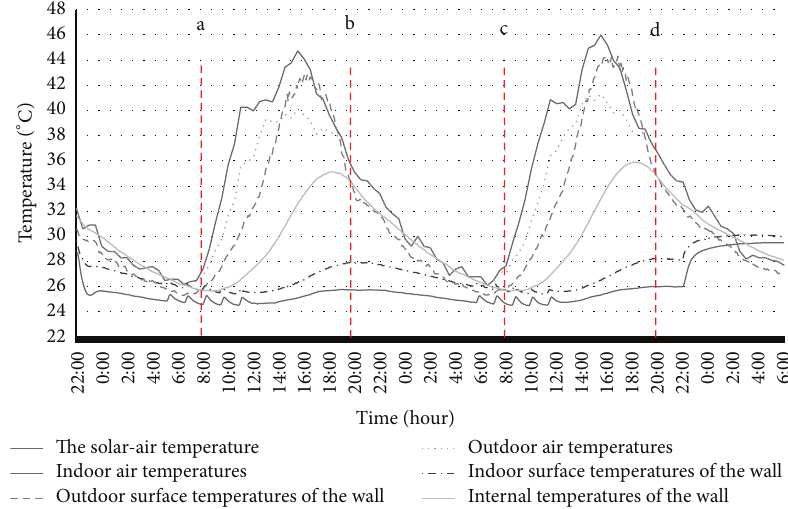
Figure 2: Testing-point temperatures of externally insulated wall in continuous running state of